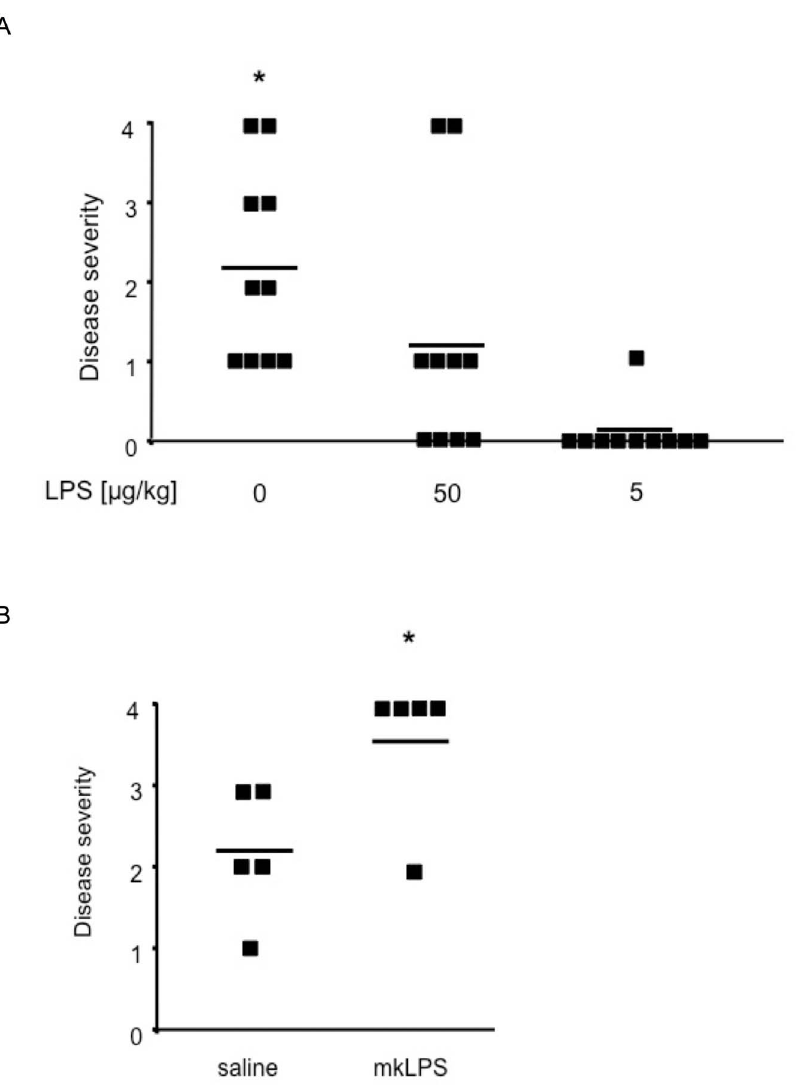
Figure 2. TLR4 signaling is crucial for prevalence and severity of experimental autoimmune myocarditis. (A) Systemic administration of low dose LPS curbed the induction of experimental autoimmune heart disease. Wild type BALB/c mice treated with low doses LPS developed myocarditis with significantly reduced severity and prevalence compared to saline treated controls. Mice were immunized with M7A a peptide in CFA and treated by intraperitoneal injection 3 times, on days 5, 9, and 13 after the initial immunization, with the indicated doses of highly pure LPS or saline. Squares represent individual mice, lines indicate mean values. * p , 0.05 when compared to other groups using ANOVA for multiple-sample comparisons (Bonferroni). (B) Antagonizing the LPS receptor TLR4 significantly increased severity of autoimmune myocarditis. mkLPS, which lacks the myristoyl fatty acid moiety of lipid A, antagonized TLR4 signaling through direct interaction with TLR4. Mice immunized with M7A a peptide in CFA and mkLPS developed significantly more severe myocarditis than control mice receiving M7A a peptide in CFA and saline. Disease severity was determined by histopathology 21 days after the initial immunization. Squares represent individual mice, lines indicate mean values. * p , 0.05 by Student;s t-test. One representative result out of 4 independent experiments is